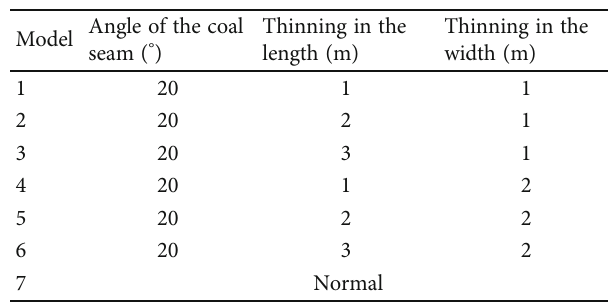
Table 2: Models for analyzing the in fl uence of thinning on the No. 11 coal